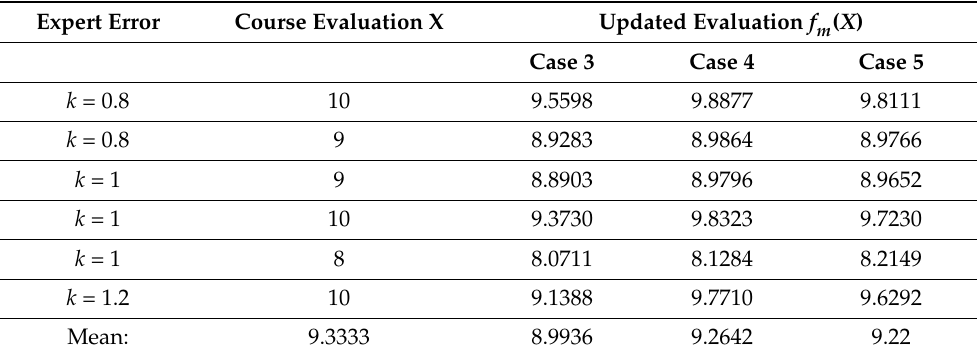
Table 12. True and upgraded ‘Building management’ course grades; µ = 8.864 , σ = 0.995. Expert